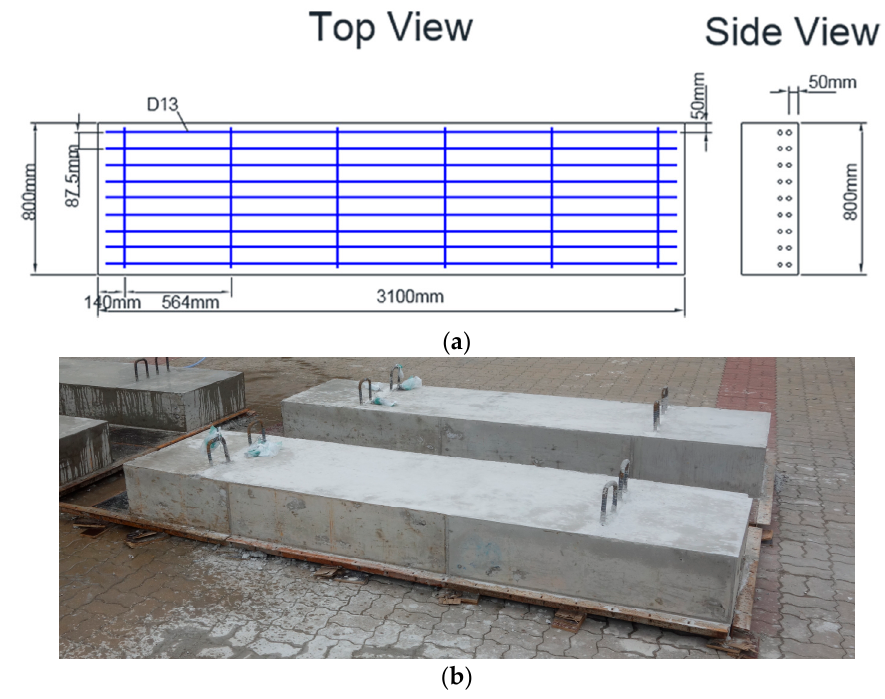
Figure 5. Concrete wide beam test specimen. ( a ) The planar and side views; ( b ) the test specimen after casting.